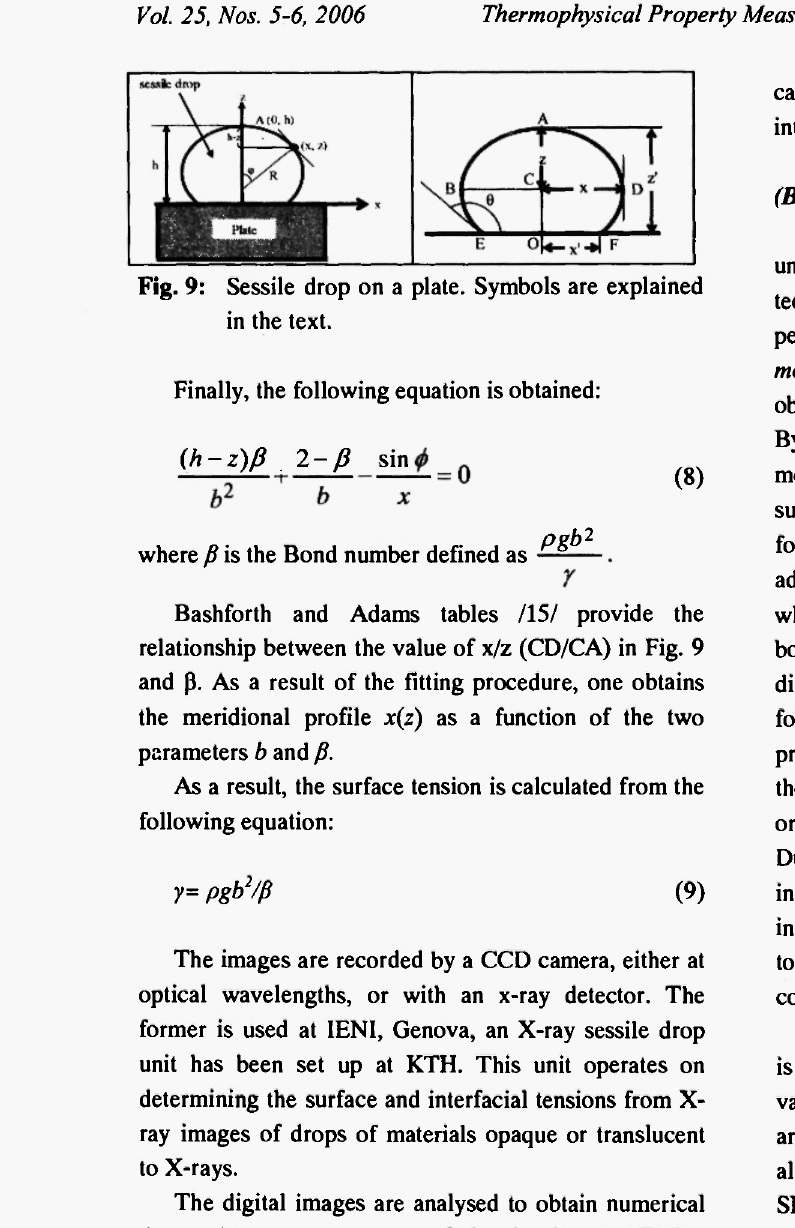
Fig. 9: Sessile drop on a plate. Symbols are explained in the